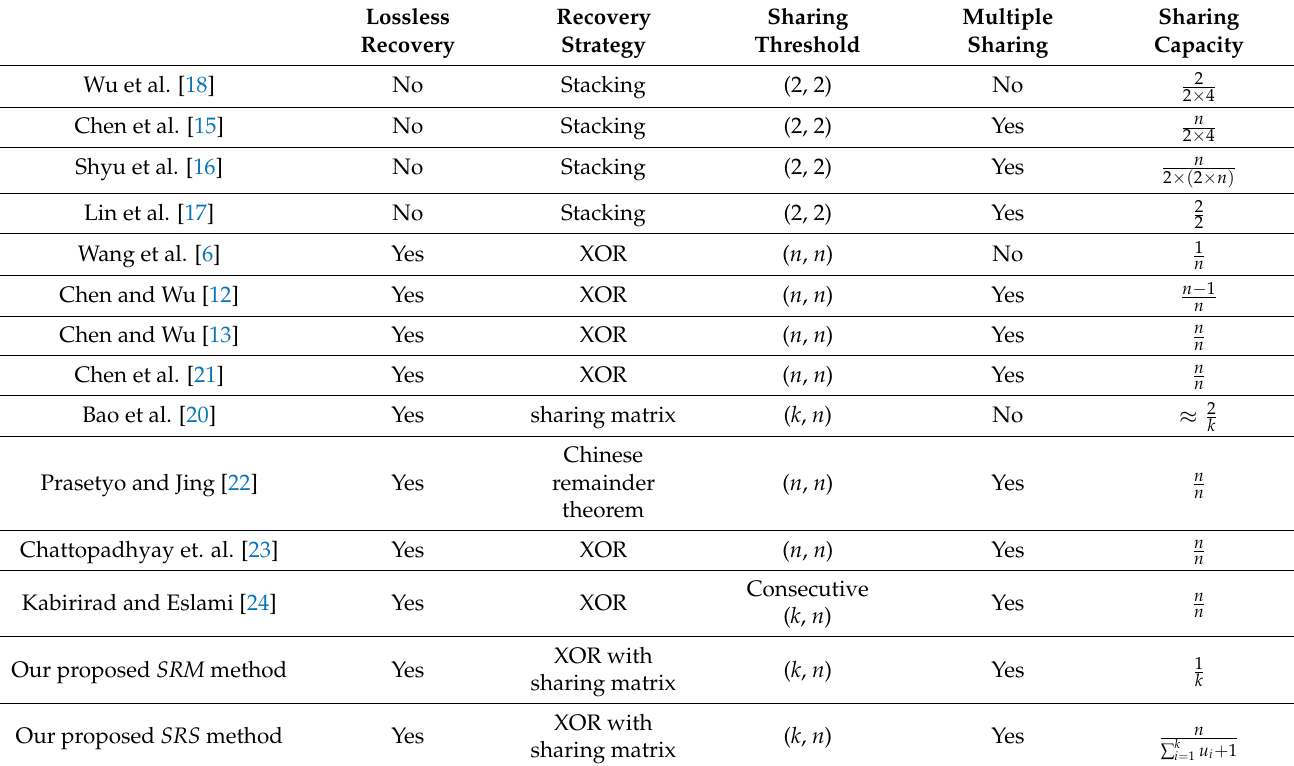
Table 2. Comparisons between the two proposed approaches and related multiple secret image sharing